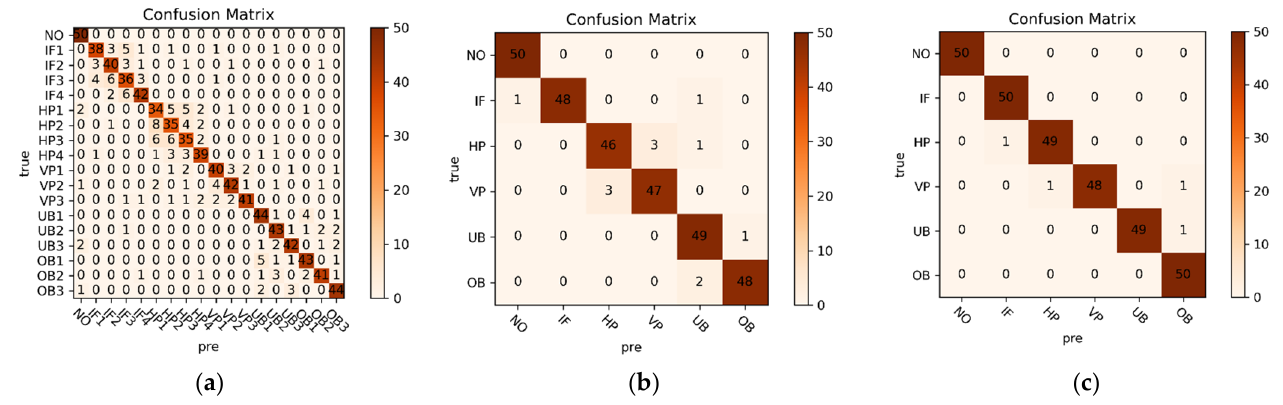
Figure 7. The confusion matrix of the network: ( a ) the diagnostic results of dataset A in Attention–TCN; ( b ) the diagnostic results of dataset B in Attention–TCN; ( c ) the diagnostic results of dataset C in Attention–TCN.